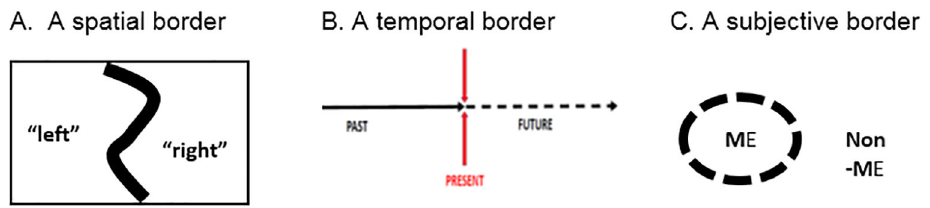
Figure 1. Making distinctions as an act of creating